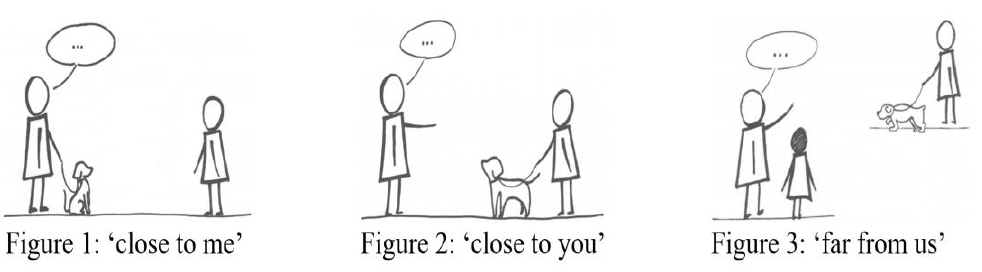
Figure 3 . Elicitation test for demonstratives, Microcontact project